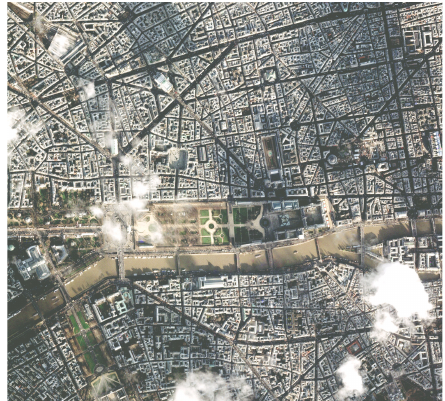
Figure 1. The first images acquired by the Pléiades system highlight one of the primary problems that satellite acquisition generally copes with: the presence of clouds in the scene. A view over the historical part of Paris